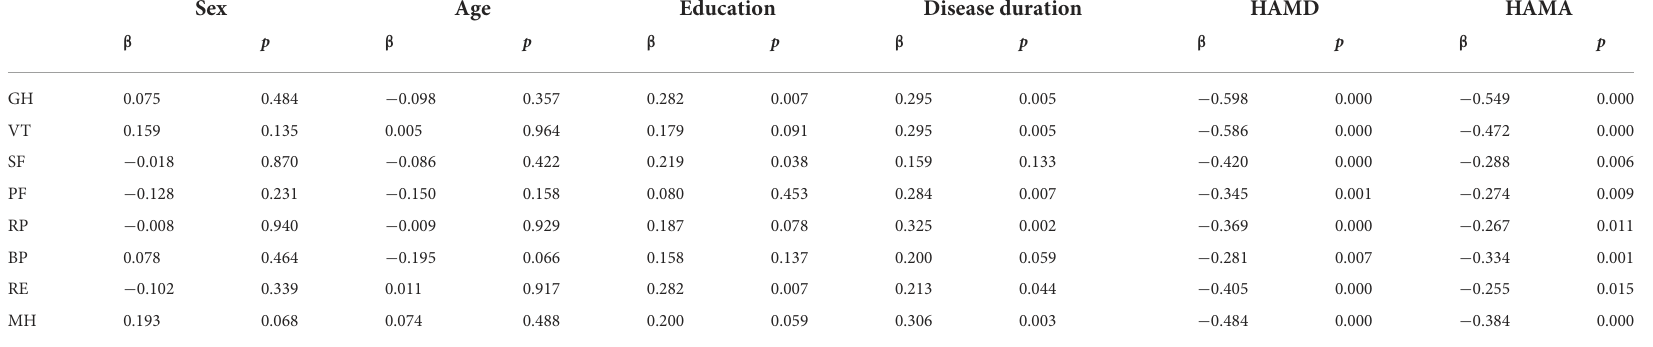
TABLE 4 Factors correlation with the eight domains of SF-36.